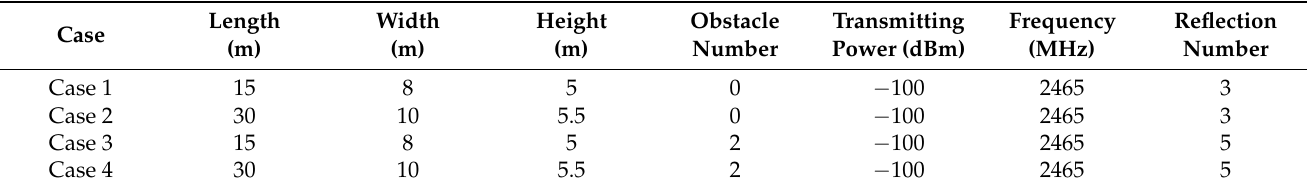
Figure 3. Simulation scenario of ray-tracing system. Table 1. Environment information for four